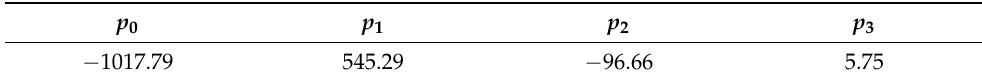
Figure 9. Sensing test of the crawling robot. ( a ) The third-order polynomial used to capture the relationship between the SCPAM string resistance and bending angle. ( b ) Graph of the sensing effect (estimated bending angles compared with actual bending angles). Table 2. Identified parameters of the third-order